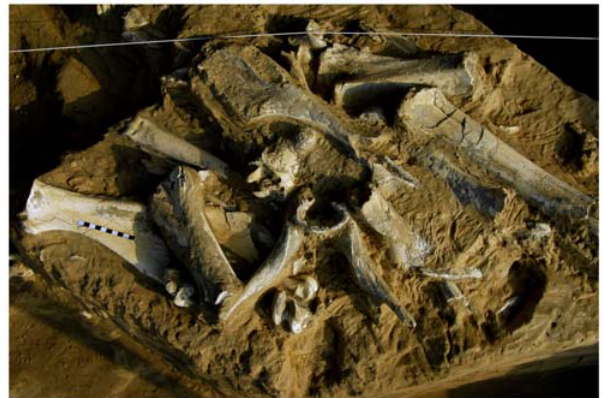
Figure 3. Plan view of part of Fonelas P-1 site (Trench B) with skulls of Gazellospira and Metacervoceros (both of them gnawed by hyaenids) and long bones of Equus and Mammuthus (juvenile individuals gnawed by hyaenids).